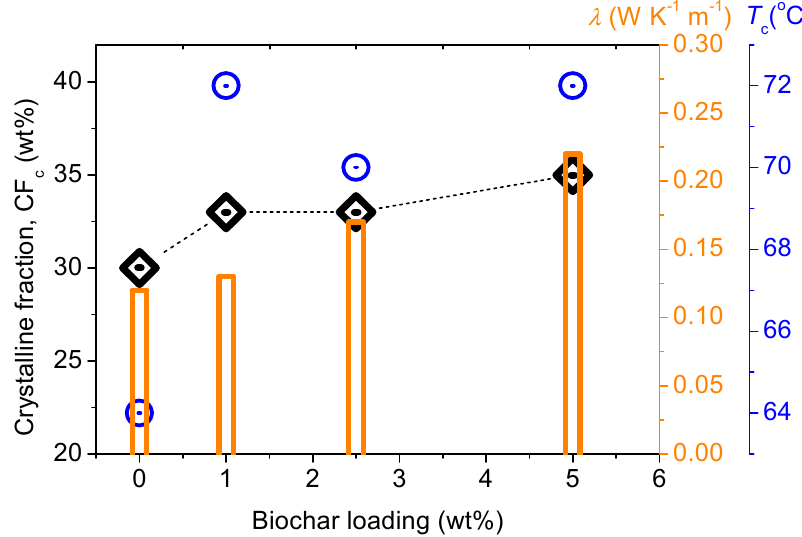
Figure 8. Effects of composition on (left axis, black diamonds) crystalline fraction, comparatively with (right axis, blue circles) crystallization temperature and (orange columns) thermal conductivity (LFA).